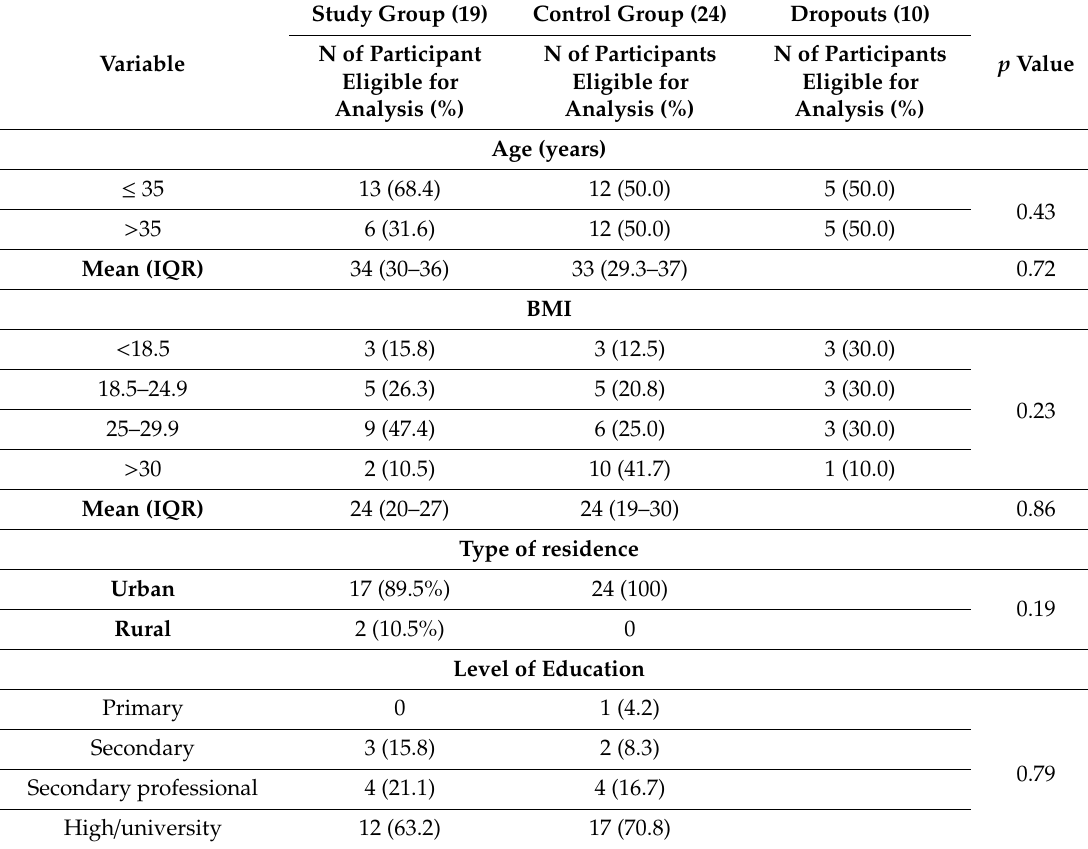
Table 1. The demographic characteristics of patients from study, controls and drop outs